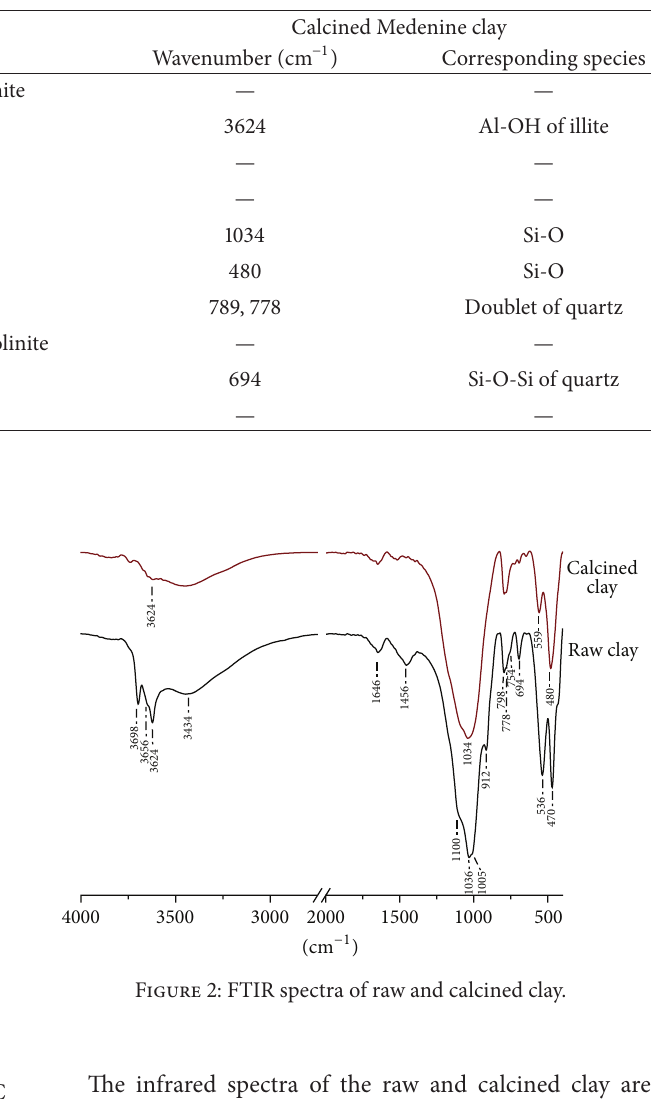
Figure 1: XRD patterns of raw and calcined Medenine clay at 700 ∘ C for 5 hours. Q: quartz (00-046-1045), K: kaolinite (00-001-0527), I: illite (00-024-0495), H: hematite (00-024-0072), G: gypsum (04- 009-3817), M: muscovite (00-001-1098), and D: dolomite (01-075- 1655).